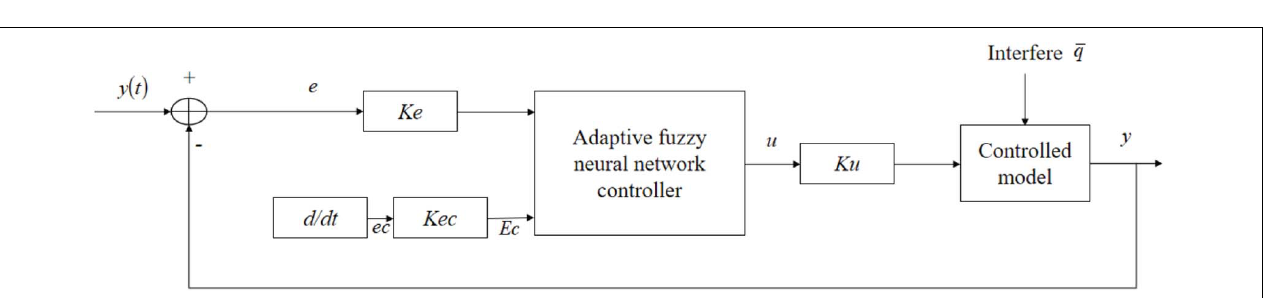
FIGURE 2 | Information processing flow of MAS task dispatching in distributed control system.